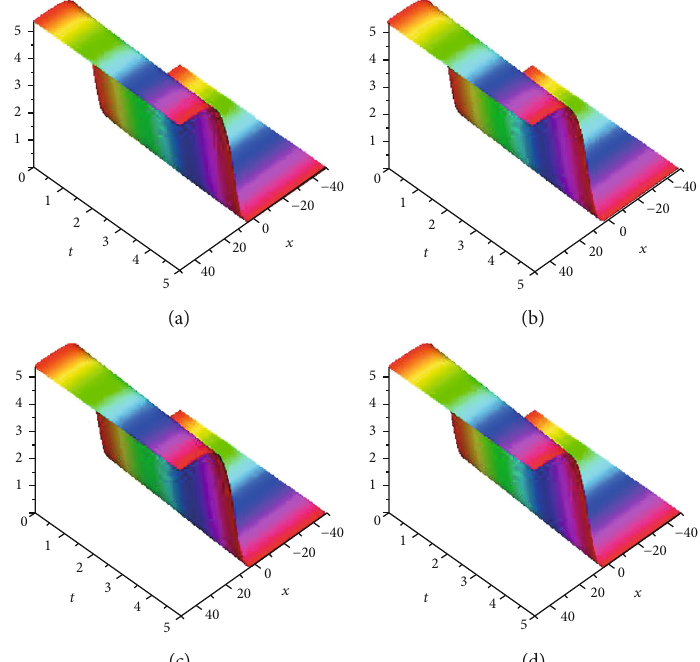
= 1 : 5 , q = 2 , λ = 2 : 2 , M = 3 , N = 2 , and k = 3 , when (a) α = 0 : 25 , (b) α = 0 : 5 , (c) α = 0 : 85 , 2 2